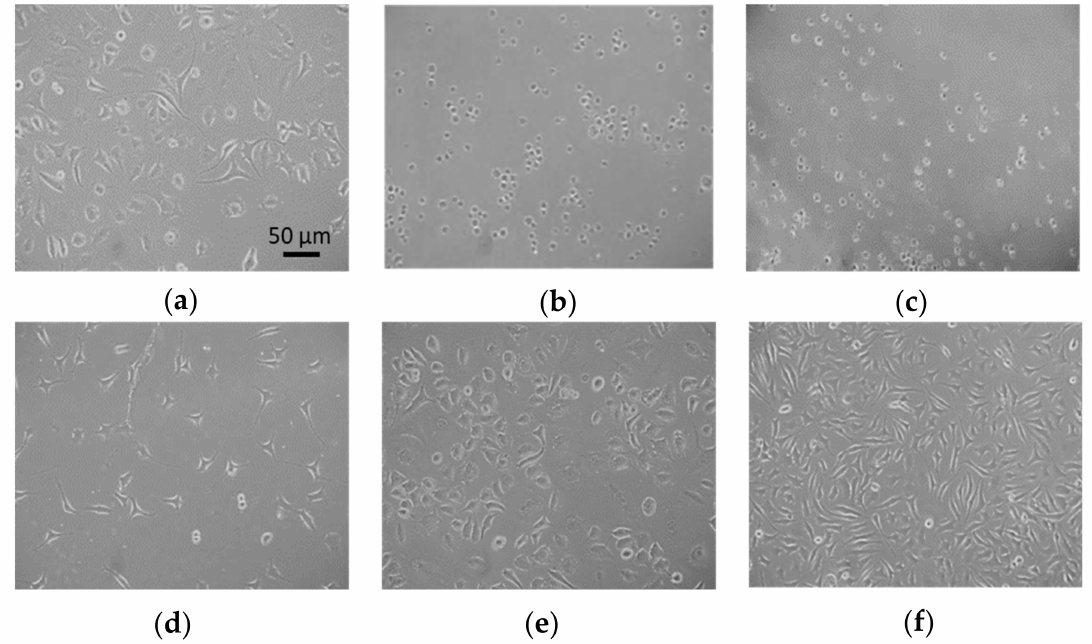
Figure 7. Optical microscopy images depicting the adhesion and morphology of L929 fibroblasts after 4 days in culture on the ( a ) TCPS control, ( b ) P(PTPAE- alt -AD), ( c ) PE-Prop50, ( d ) PE-Glyc50, ( e ) PE-Prop80, and ( f ) PE-Glyc80 films. Scale bar represents 50 µ m and is the same in all